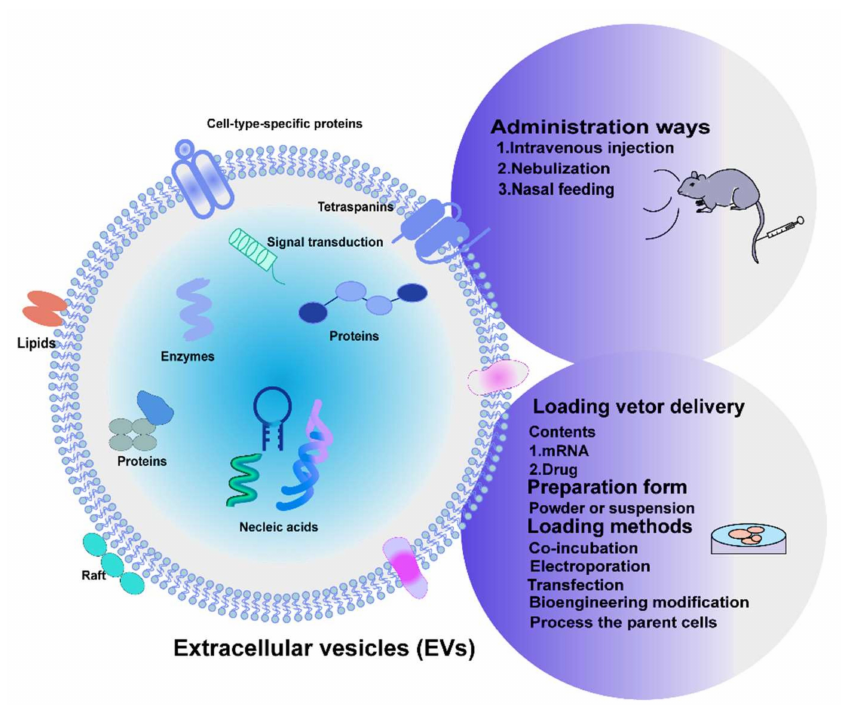
Figure 3. Overview of therapeutic modalities of MSC-EVs for IPF. Administration routes in EVs- based strategies applicable in IPF. MSC-EVs loading techniques to produce target and effective EVs-based